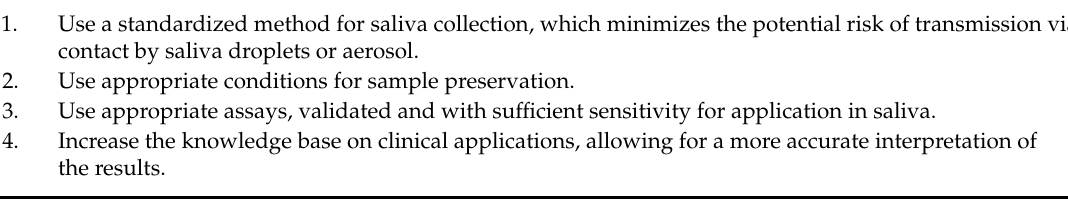
Table 1. Recommendations for the use of saliva as sample in